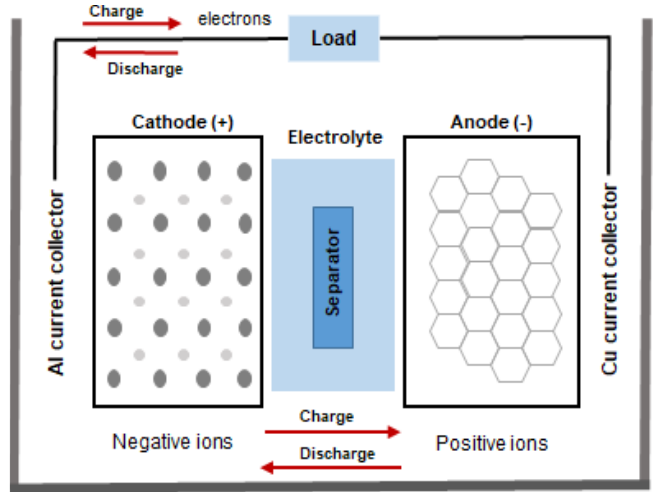
Figure 1. A schematic diagram showing how a lithium – ion battery works.